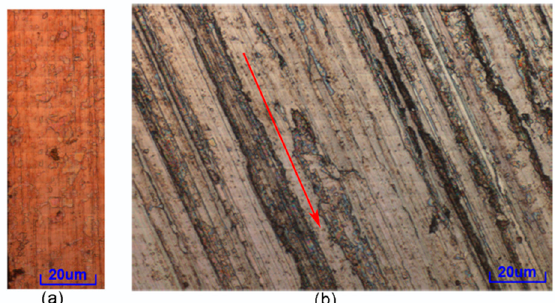
Figure 25. Local magnified surface topography of the micro ‐ die: ( a ) bar region and ( b ) bottom region. The arrow represents the machining marks.